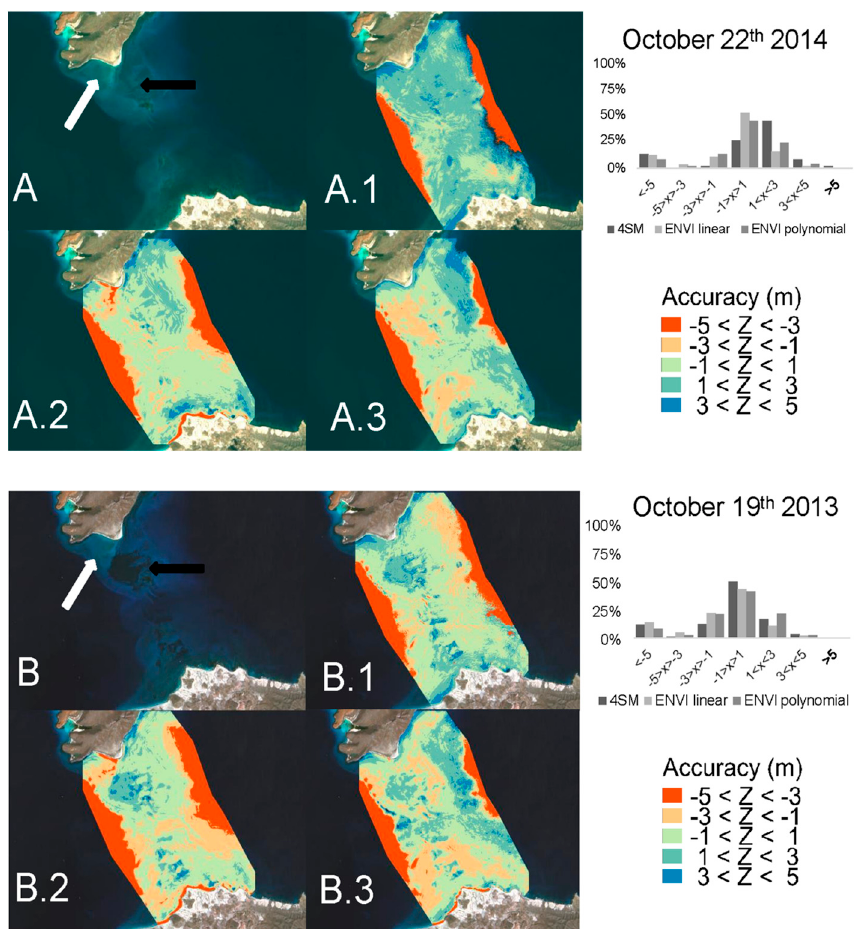
Figure 7. Results of the accuracy assessment on retrieved depth for 4SM and ENVI/SPEAR tool methods. The accuracy index is classified as follow: blue tones for two depth overestimation classes, red tones for two depth underestimation classes, and turquoise tone where the residual is less than 1 meter. Barplots show the percentage of pixels that belong to each of these classes. ( A ) is a Landsat RGB color composite view of 22 October 2014, white arrow indicates an example of bright shallow bottom, while black arrow represents darker shallow bottoms. ( A.1 ) is 4SM accuracy index; ( A.2 ) is the accuracy index calculated on ENVI-SPEAR with line model calibration; ( A.3 ) is the accuracy index calculated on ENVI-SPEAR with polynomial model calibration. Topright barplot reports % of pixels belongings to each index classes: < − 5 m difference class is due to the detection limit constraint of remote sensing in coastal water, since it is represented by pixels in deeper waters. ( B ) is a Landsat RGB color composite view of 19 October 2013, ( B.1 ) is 4SM accuracy index; ( B.2 ) is the accuracy index calculated on ENVI-SPEAR with line model calibration; ( B.3 ) is the accuracy index calculated on ENVI-SPEAR with polynomial model calibration. Topright barplot reports % of pixels belongings to each index classes calculated on the scenes.